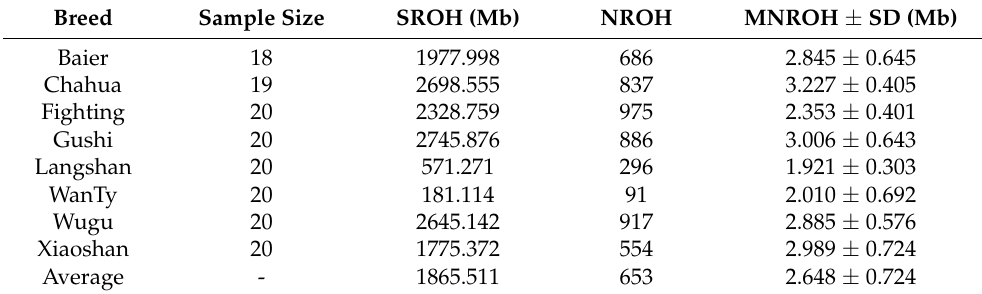
Table 2. Statistics of